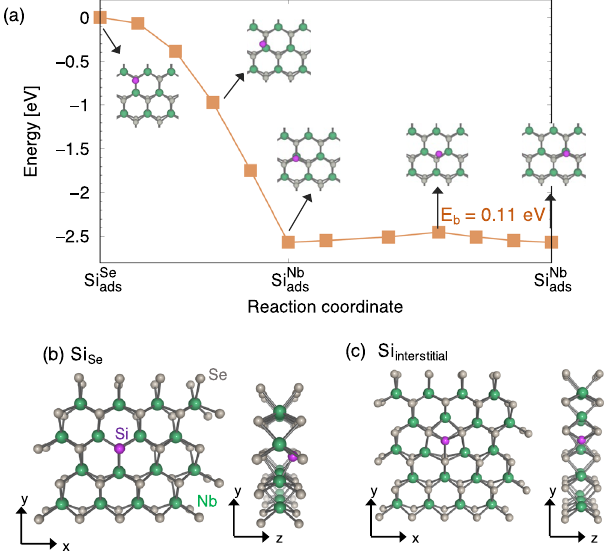
Fig. 4 Adsorption and migration properties of Si in NbSe 2 . a Theoretical minimum-energy pathway for Si adatoms on NbSe 2 to migrate from the Si Se metastable adsorption site to Si Nb . The migration barrier to hop ads ads between Si Nb sites is 0.11 eV. The energies are reported with respect to the ads total energy of Si Se . Schematic top view and side view of ( b ) Si substituted ads on the Se site, Si Se and ( c ) Si incorporated interstitially within the same plane as the the Nb atoms, Si i Fig. 4b, Si is bonded to three nearest-neighbor Nb atoms with a Si-Nb bond length of 2.615 Å , which is 4.5% shorter than the equilibrium Nb-Se bond length.